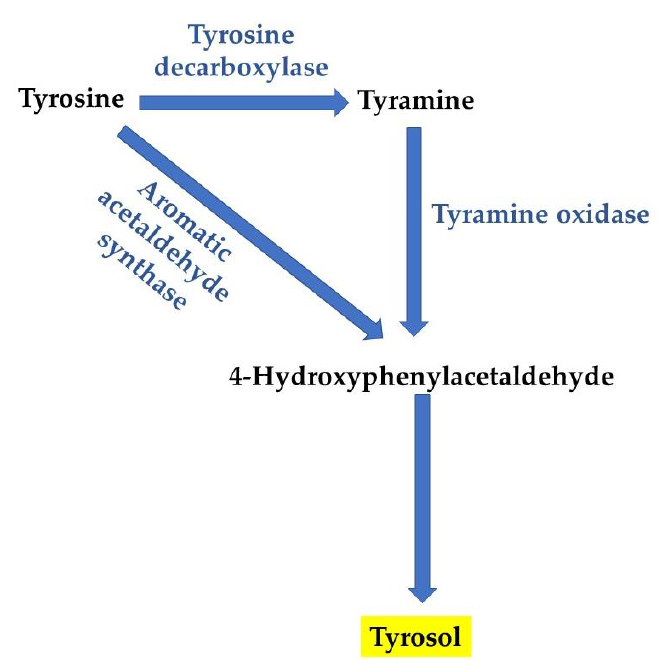
Figure 4. Scheme of Tyr biosynthesis, according to Reference [50].